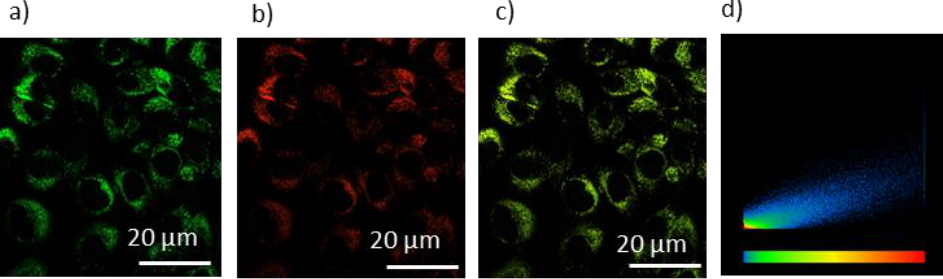
Figure 6. Hela cells costained with ( a ) 10 μM 4O (λ ex = 405 nm, λ em = 600 nm) for 30 min and ( b ) 50 nM LysoTracker deep red for 1 h (λ ex = 647 nm, λ em = 655 nm) in PBS and fluorescence images ac- quired by confocal microscopy. ( c ) An overlay. ( d ) Colocalization analysis plot of the LysoTracker and 4O . Pearson’s overlap coefficient, R P = 0.82.